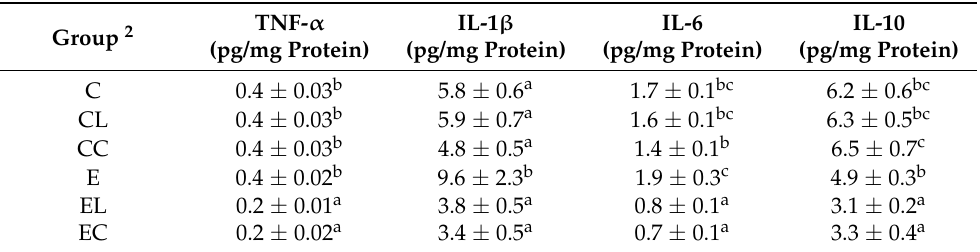
Table 10. Effects of different dietary fat sources on hepatic interleukin (IL)-1 β , IL-6, IL-10, and tumor necrosis factor (TNF)- α levels in rats 1